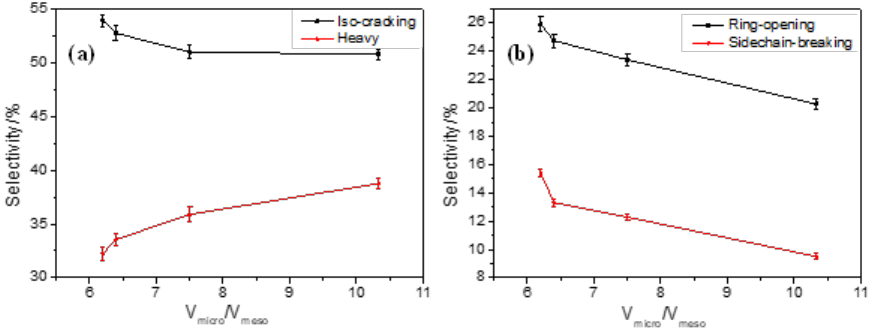
Figure 13. The path selectivity of MAZ zeolite at 45% conversion rate vs. V micro /V meso . ( a ) The selectivity of Iso-cracking and Heavy vs. V micro /V meso and ( b ) The selectivity of Ring-opening and Sidechain-breaking vs. V micro /V meso .